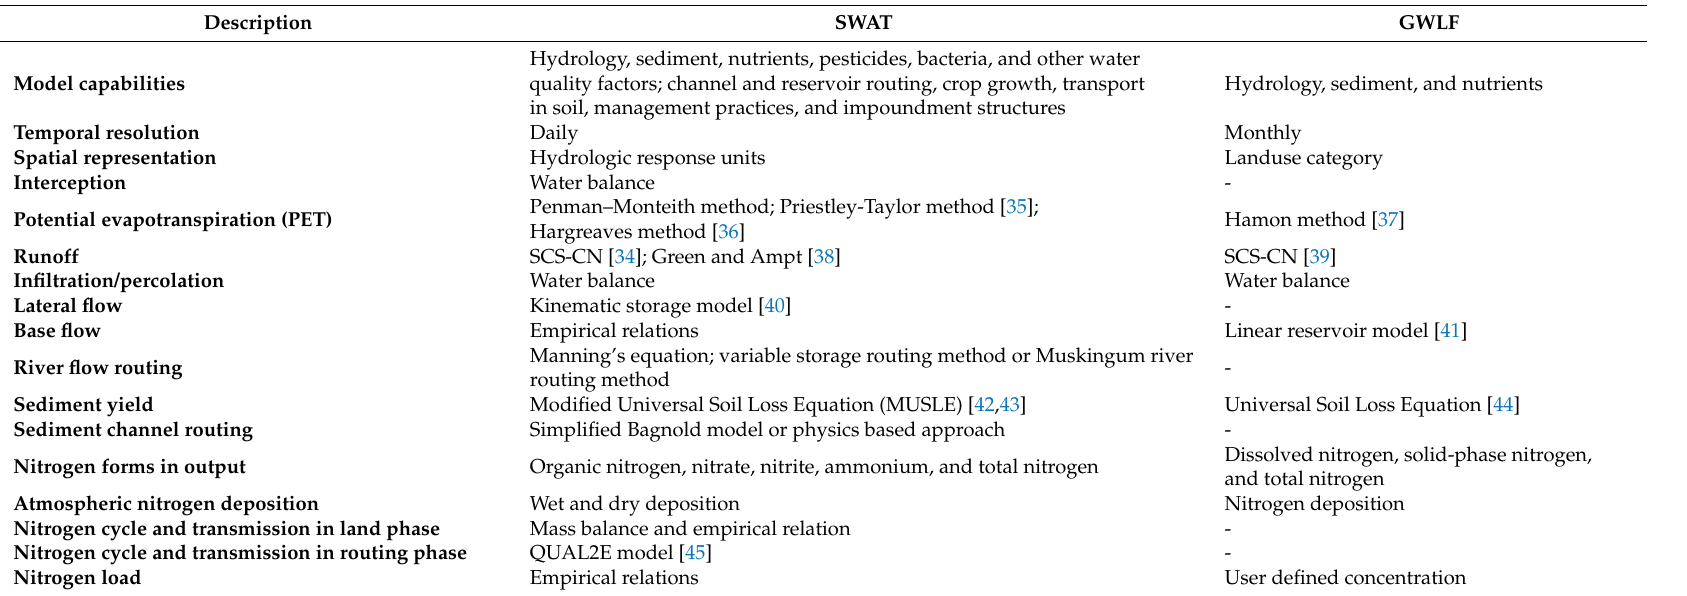
Table 1. Summary of the major processes and related methods used by SWAT and